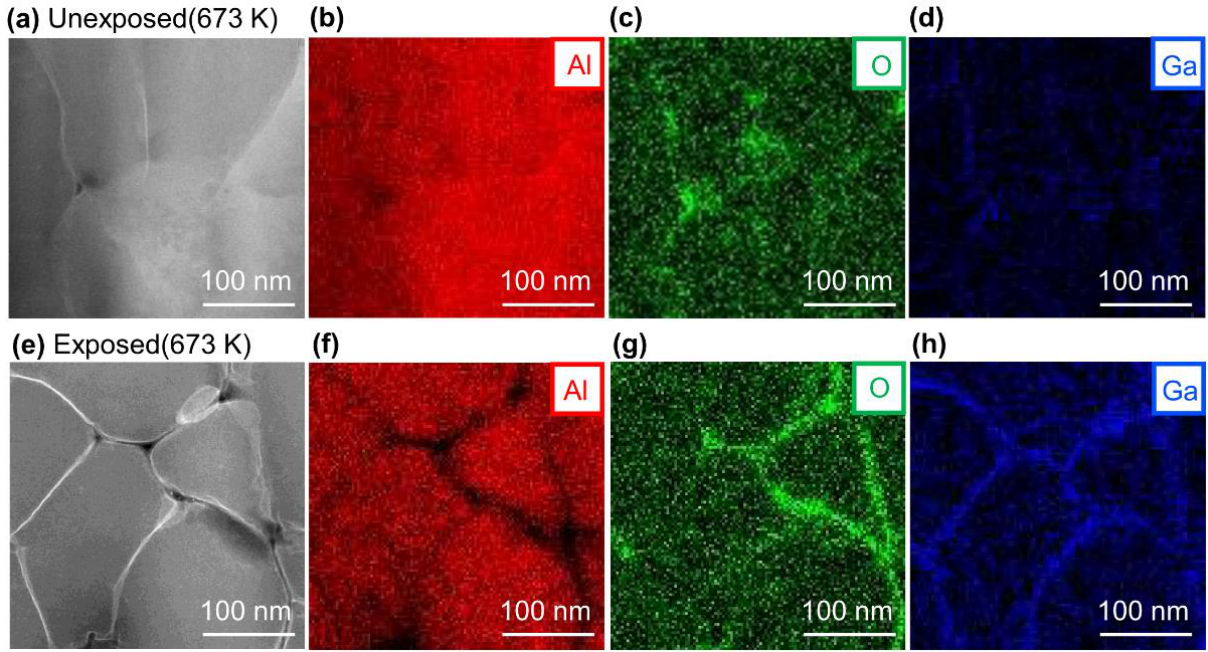
Figure 3. ( a ) high-angle annual dark-field (HAADF)-STEM image and EDS mapping results of ( b ) Al, ( c ) O, and ( d ) Ga of unexposed Al compact sintered at 673 K under 600 MPa for 1 min, and ( e ) HAADF-STEM image and EDS mapping result of ( f ) Al, ( g ) O and ( h ) Ga of exposed Al compact sintered at 673 K under 600 MPa for 1 min.